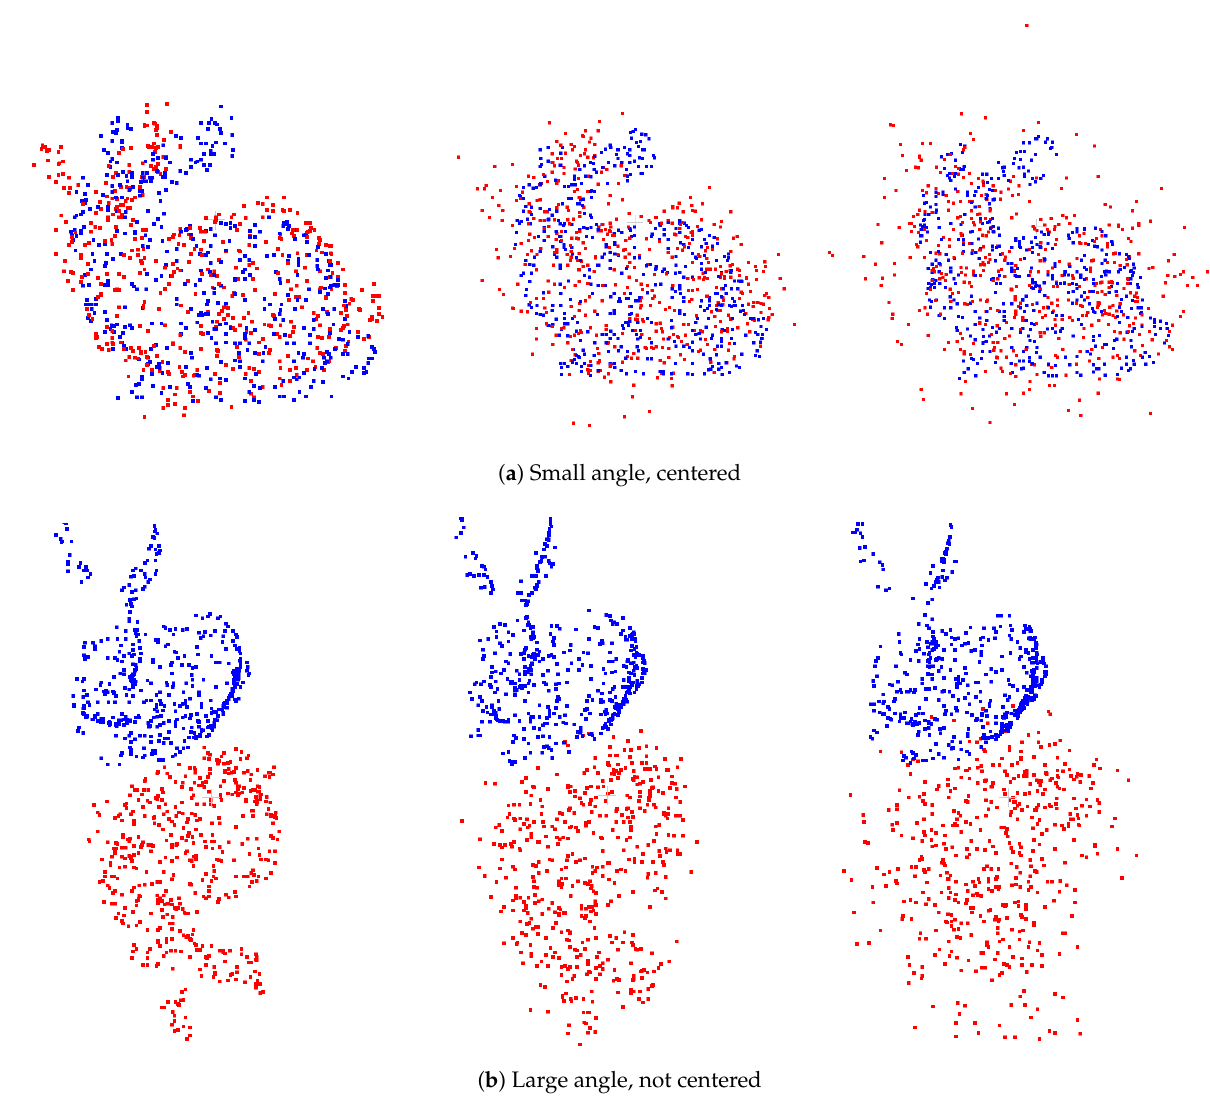
Figure A4. Noise data: (top) centered small angle; and (bottom) large angle. From left to right column is with noise standard derivation 0.002, 0.01, and